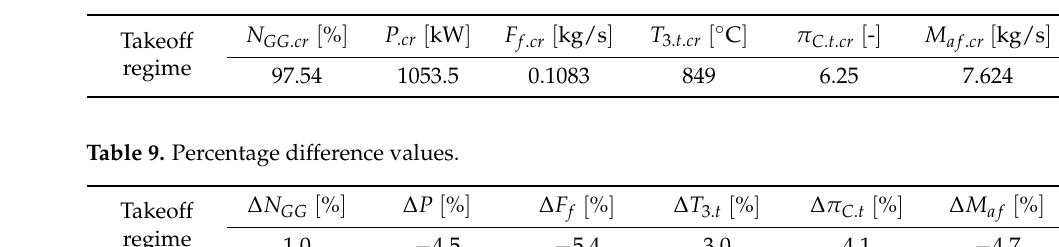
Table 8. The corrected measured data.